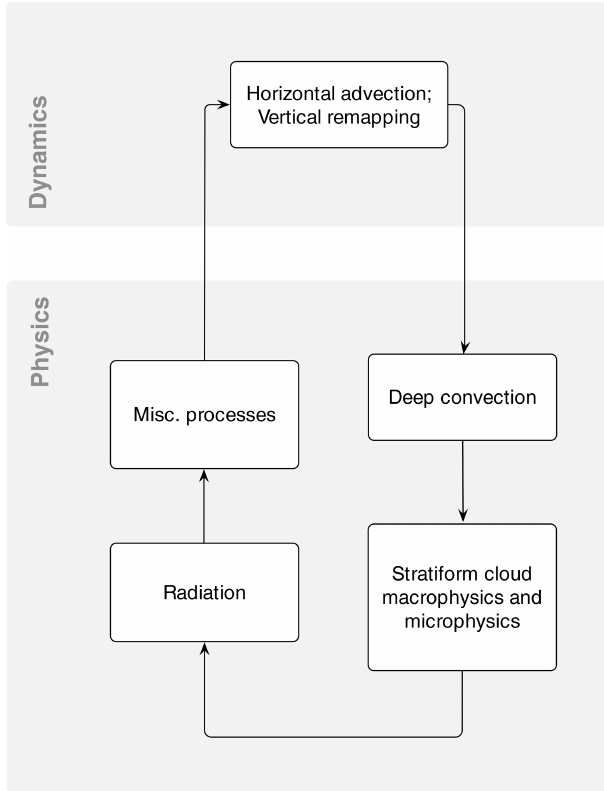
Figure 1. A simplified schematic showing the sequence of calcu- lations in EAMv1. Each box is viewed as a coarse-grained compo- nent (which might contain subcomponents corresponding to differ- ent atmospheric processes). Time step sizes used by these coarse- grained components and their coupling are described in Sect. 2.1 and Fig.